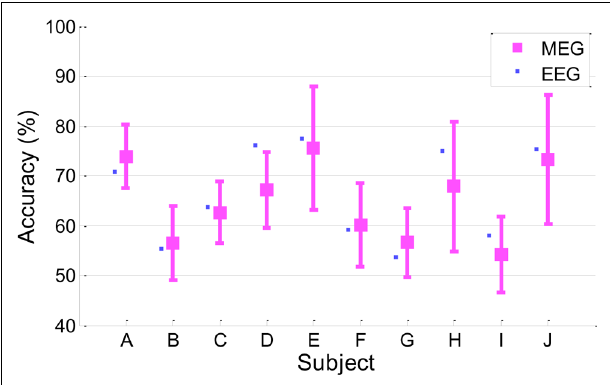
FIGURE 6 | Classification accuracy in MEG. MEG accuracy of each subject is presented as a mean with a standard deviation, and for comparison, EEG accuracy is plotted as a small filled square ( r = 0.91, p < 0.0005).